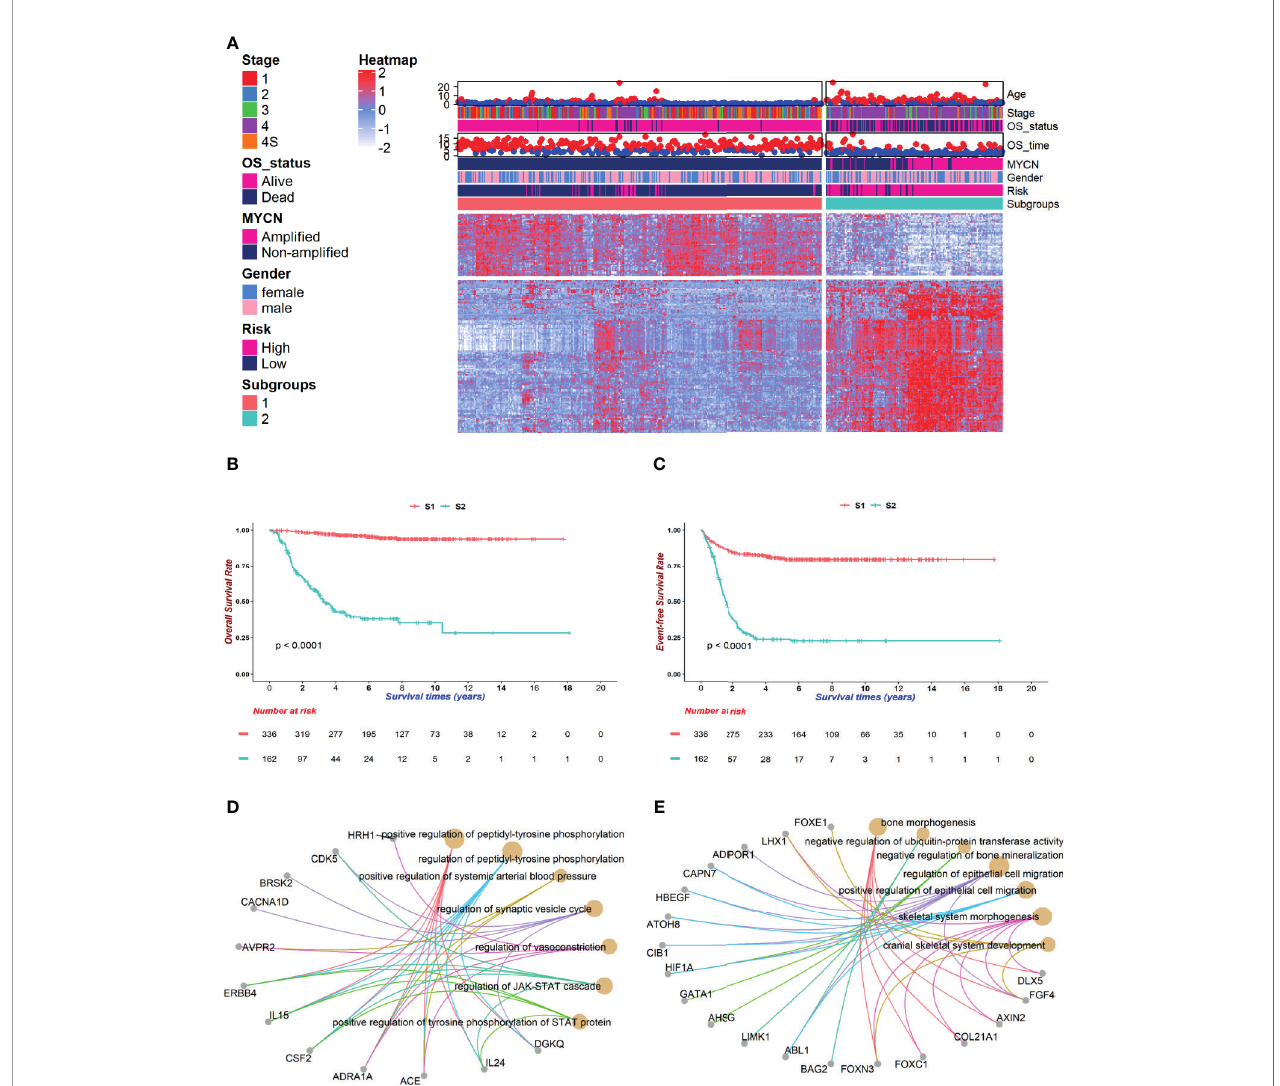
FIGURE 2 | The genomic atlas of neuroblastoma was characterized by 172 genes. After implementing the chi-square test between gene expressions and survival status, a total of 172 genes were selected for following investigations. Patients were clustered into two groups, named subgroup 1 (S1) and subgroup 2 (S2), which owned 50 and 122 markers respectively. (A) The heatmap portraited the neuroblastoma genomic landscape in GSE49710. Gene expressions were normalized among samples. The higher expressions reached red while lower reached white. Corresponding clinical information, including age, stage, vital status, survival time, MYCN ampli fi cation, gender, INSS risk and subgroups, was attached on the top of the heatmap. (B, C) Kaplan-Meier (KM) curves showed distinct survivals between S1 (coralline line) and S2 (atroceruleous line) in overall survival (OS) (B) and event-free survival (EFS) (C) (log rank test p < 0.001 for each). (D, E) GO-enrichment analysis for feature 1 (F1) and feature 2 (F2) showed that S1 was up-regulated in the JAK-STAT pathway (D) and S2 was up-regulated in bone morphogenesis (E)